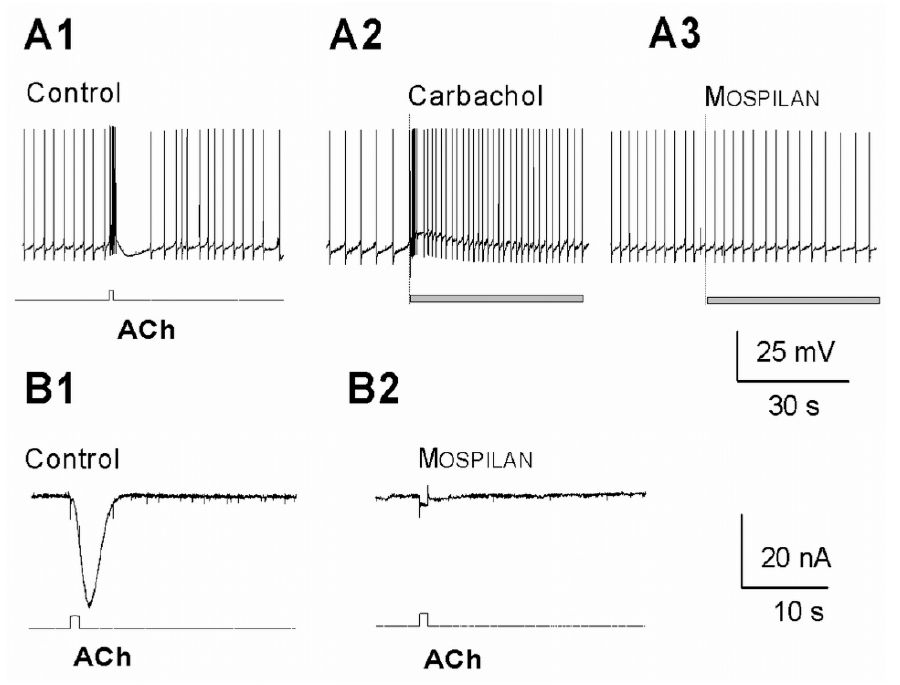
Figure 7. Intracellular responses of the identified Helix pomatia neurons. In normal saline (control) local application of 1 mM ACh evokes strong intracellular response (A1) and carbachol (100 μ L, 1 mM) similarly increases the firing frequency (A2), while M OSPILAN (100 μ L, 1 mg/mL) does not alter the spontaneous activity (A3). B. Voltage clamp recording showing that the ACh-evoked inward